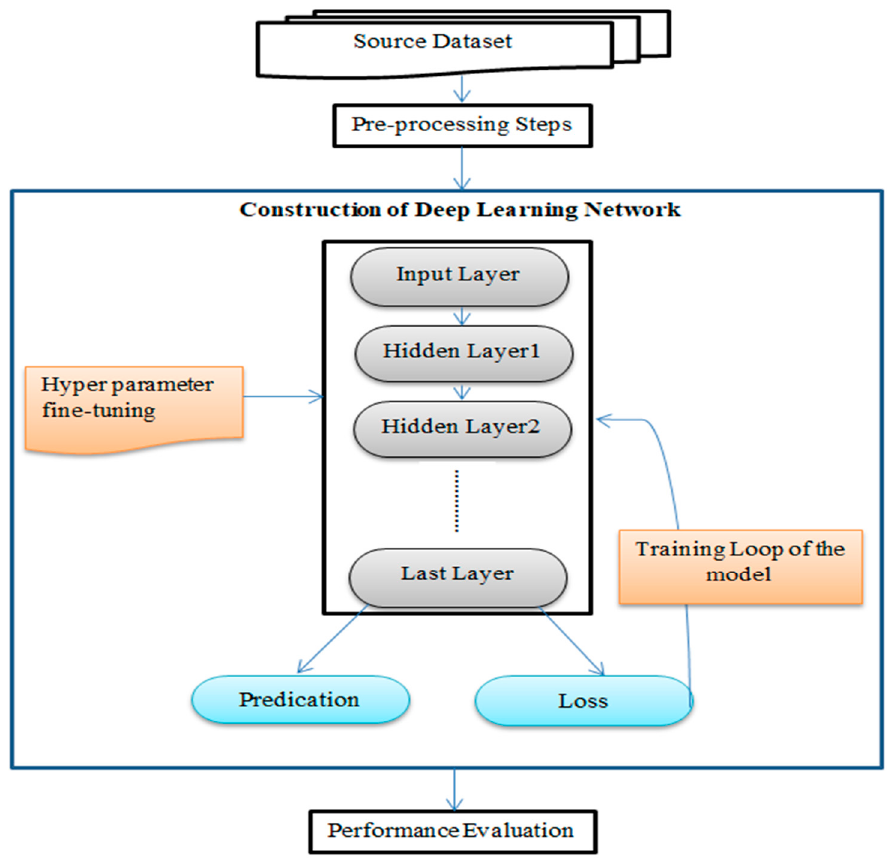
Figure 6. Processing level of DL techniques.